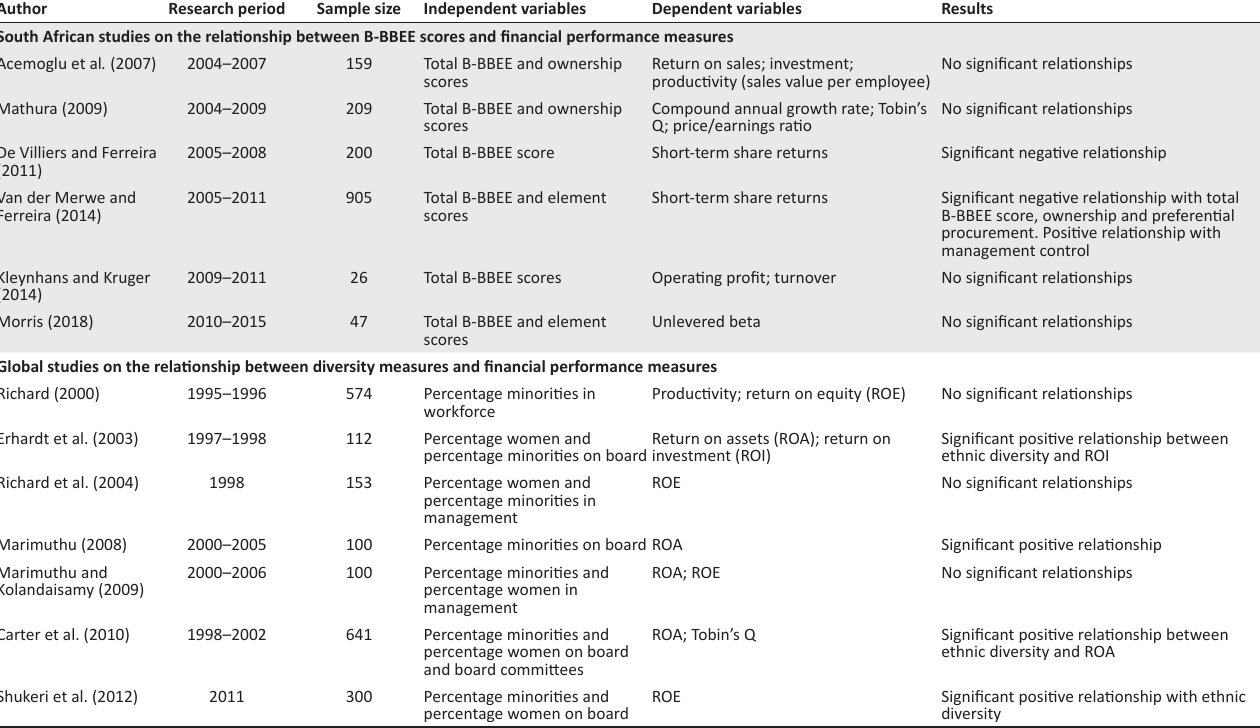
TABLE 2: Overview of studies on empowerment and financial performance